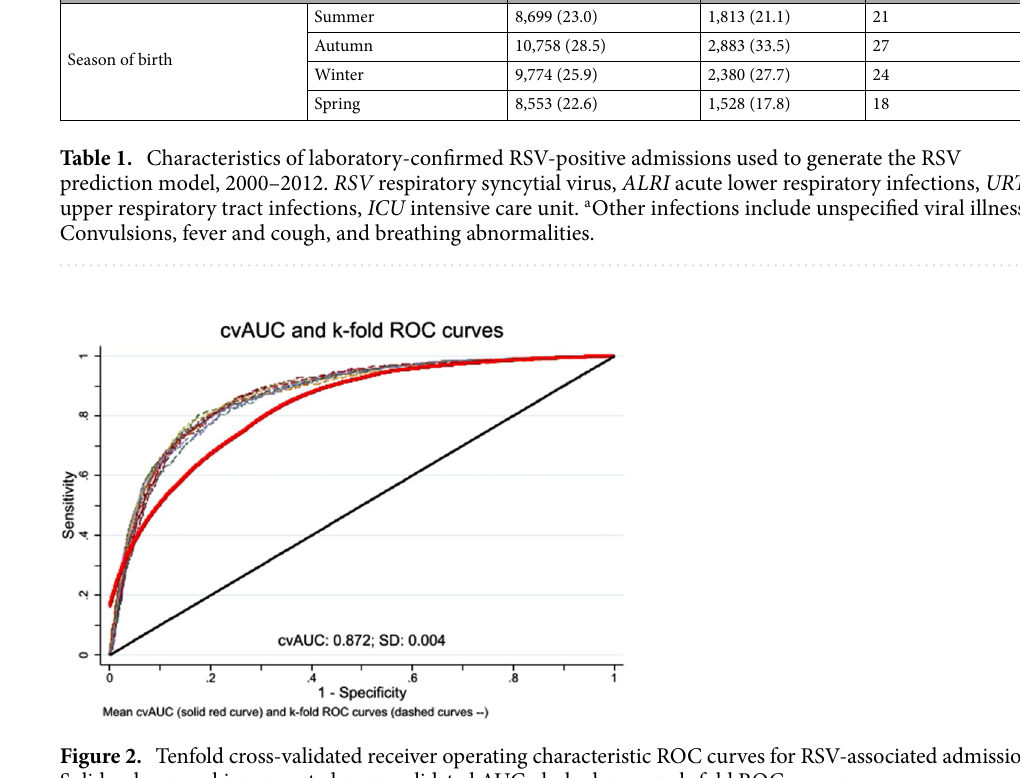
Figure 2. Tenfold cross-validated receiver operating characteristic ROC curves for RSV-associated admissions. Solid red curve = bias corrected cross-validated AUC, dashed curves = k-fold ROC